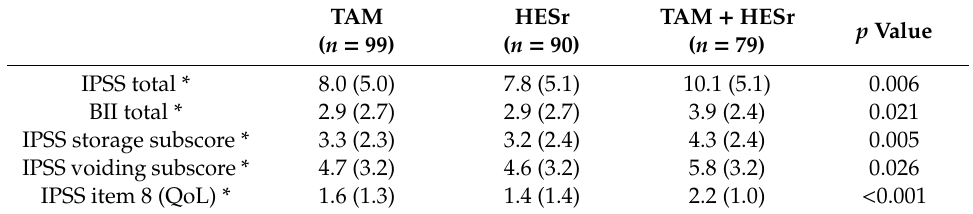
Table 3. Improvement from baseline to 6-month follow-up in symptoms and quality of life scores for the three study groups, in patients with severe (IPSS > 19) baseline symptoms (ANOVA, ITT analysis).